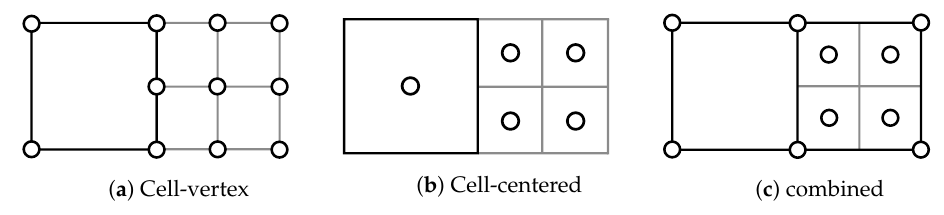
Figure 1. Grid transition interface